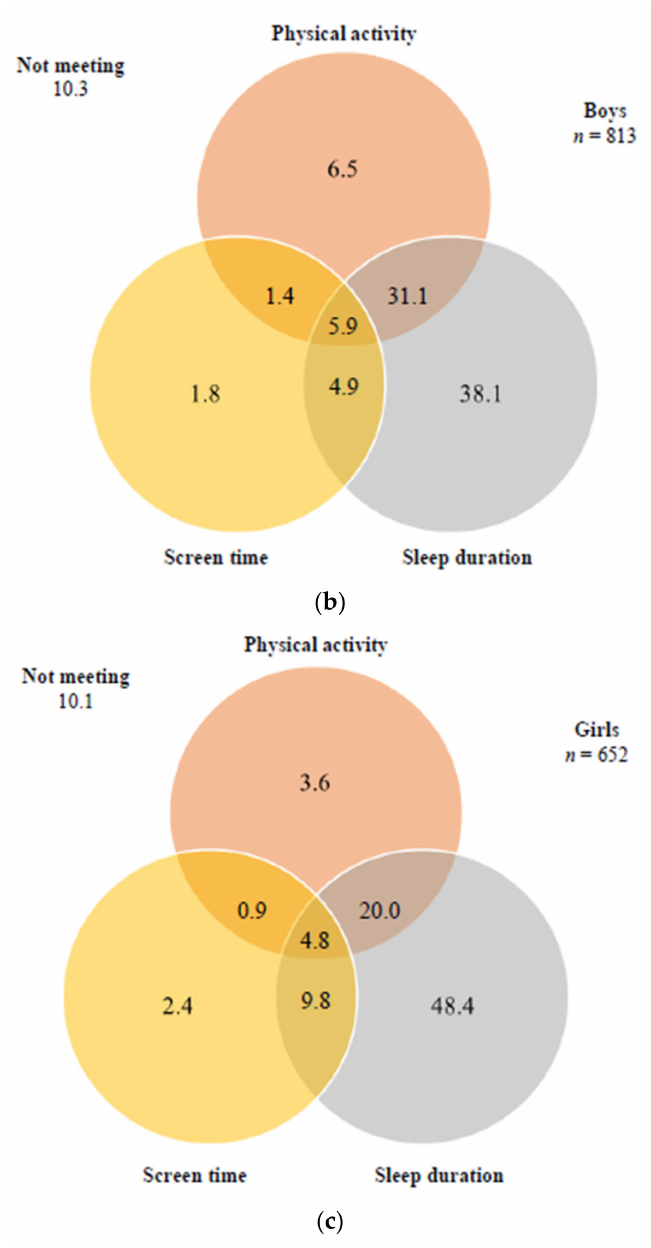
Figure 1. Venn diagram showing the proportion (%) of participants meeting 24-Hour Movement Guidelines separately and in all possible combinations. ( a ) Venn diagram showing the proportion (%) of participants meeting no guidelines; physical activity, sedentary screen time and sleep duration guidelines; and combinations of these guidelines, in the full study sample ( n = 1465). Legend: recommendations are: ≥ 60 min/day of moderate-to-vigorous physical activity; no more than 2 h/day of screen time and 8–10 h/day of sleep duration. The sum of each circle is equivalent to the % meeting each individual recommendation (i.e., 38.0% for physical activity, 15.7% for sedentary screen time and 81.3% for sleep duration); ( b ) Venn diagram showing the proportion (%) of participants meeting no guidelines; physical activity, sedentary screen time and sleep duration guidelines; and combinations of these guidelines, in boys ( n = 813). The sum of each circle is equivalent to the % meeting each individual guideline (i.e., 44.9% for physical activity, 14.0% for sedentary screen time and 80% for sleep duration); ( c ) Venn diagram showing the proportion (%) of participants meeting no guidelines; physical activity, sedentary screen time and sleep duration guidelines; and combinations of these guidelines, in girls ( n = 652). The sum of each circle is equivalent to the % meeting each individual guideline (i.e., 29.3% for physical activity, 17.9% for sedentary screen time and 83.0% for sleep